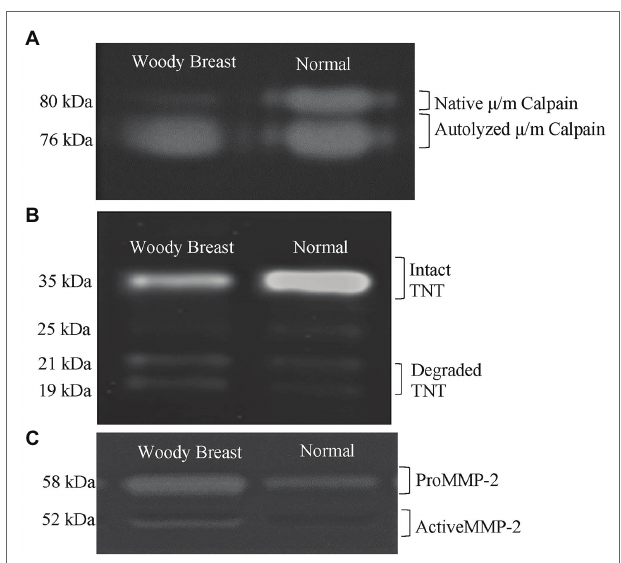
FIGURE 3 | Representative images of Woody Breast (WB) and normal (N) Pectoralis Major muscle proteins used to quantify (A) calpain activity; (B) troponin-T (TNT) proteolysis; (C) matrix metalloproteinase (MMP)